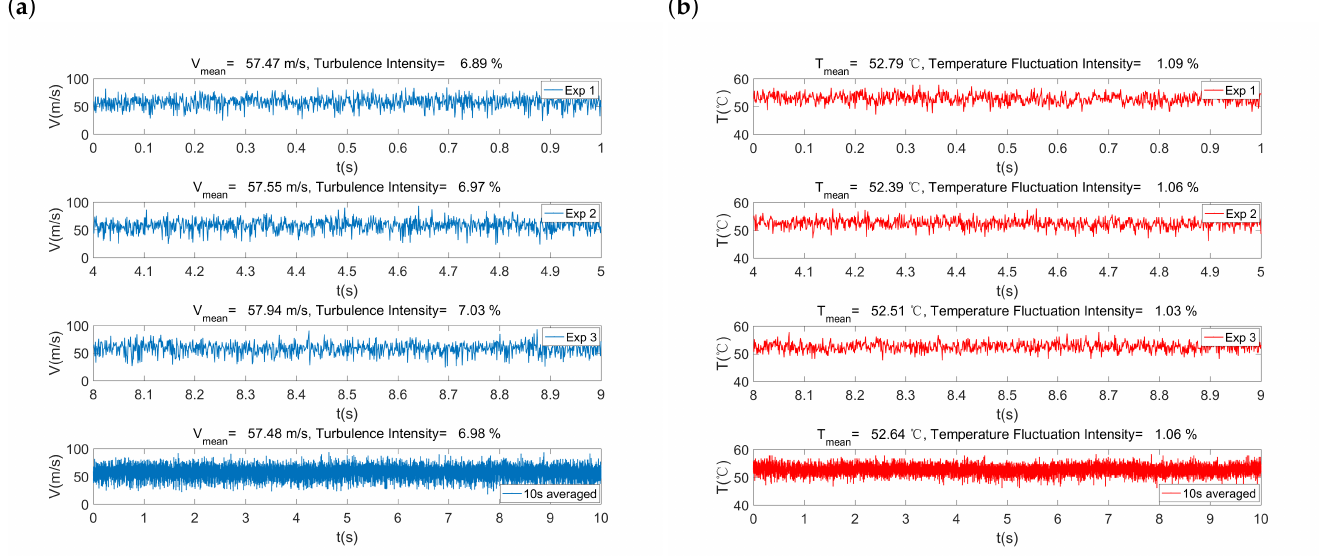
Figure 2. Example of instantaneous signal measurements at z = 24.5 mm under the original slot-die nozzle: ( a ) Instantaneous velocity and ( b ) instantaneous